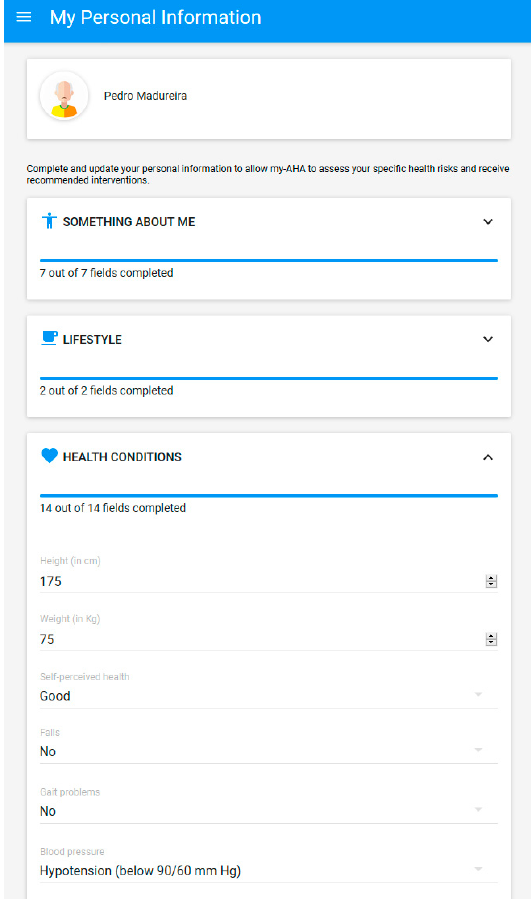
Figure 5. My Personal Information screen.